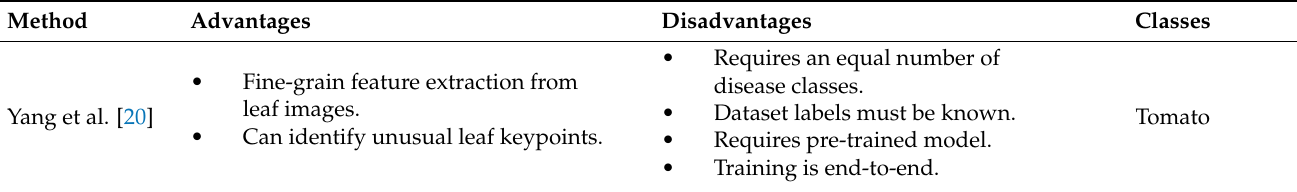
Table 1. Comparison of different